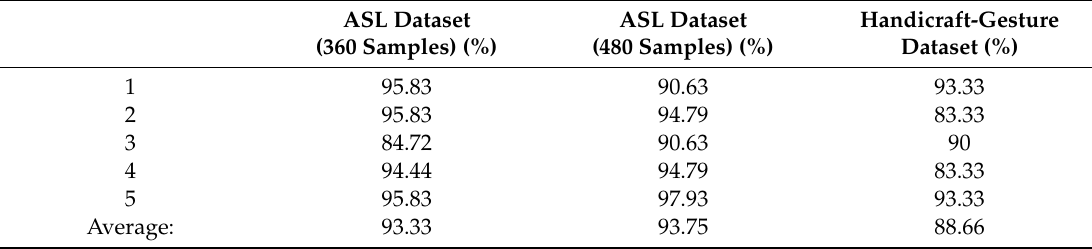
Table 4. Recognition accuracies (%) for the three datasets by using the 10-fold cross-validation method.